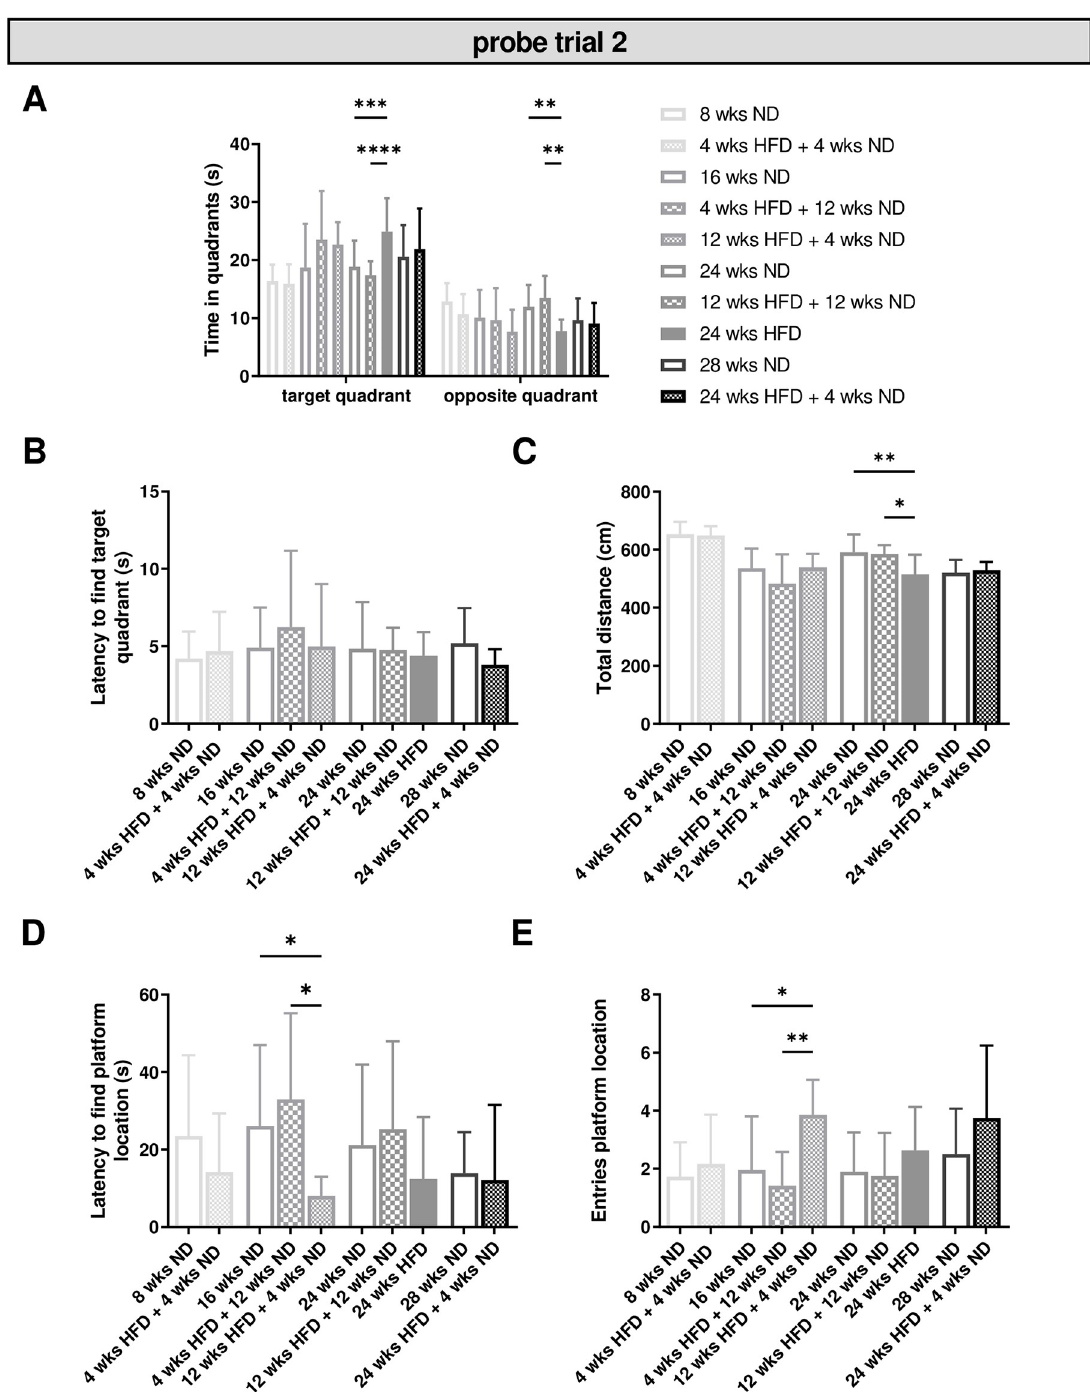
Fig 6. HFD leads to intact long-term memory, but may impair cognitive flexibility. Memory retention (probe trial two) was tested again after two days without any training in the MWM test. (A) Time mice spent in the target quadrant was significantly increased in mice receiving 24 wks of HFD compared to age-matched control mice. (B) No effect of diet was observed relative to the latency to find the target quadrant. (C) Diet had an effect on motor activity. (D, E) Dietary change showed a shorter latency to find the platform location and a significant effect on the entries of the platform location. Data are presented as mean values and error bars indicate SD; 8 wks ND n = 12, 16 wks ND n = 12, 24 wks ND n = 18, 28 wks ND n = 12, 4 wks HFD + 4 wks ND n = 12, 12 wks HFD + 4 wks ND n = 7, 4 wks HFD + 12 wks ND n = 12, 12 wks HFD + 12 wks ND n = 12, 24 wks HFD n = 10, 24 wks HFD + 4 wks ND n = 8; (A): Two-way ANOVA, (C): One- way ANOVA, (D, E): Kruskal-Wallis test; ���� p < 0.0001; ��� p < 0.001; �� p < 0.01; � p < 0.05.